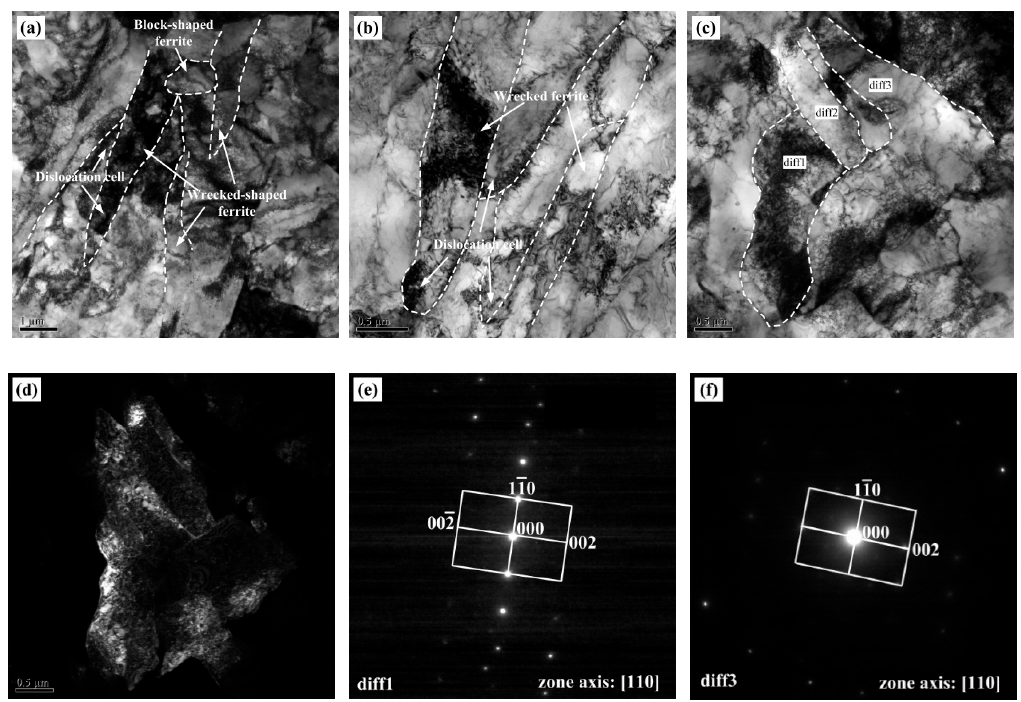
Figure 4. Micrographs from transmission electron microscope (TEM) observation for 25.4 mm X70 pipeline strip: ( a – c ) substructure, ( d ) dark-field micrograph of parallel microstructure, and ( e , f ) corresponding diffraction spots.